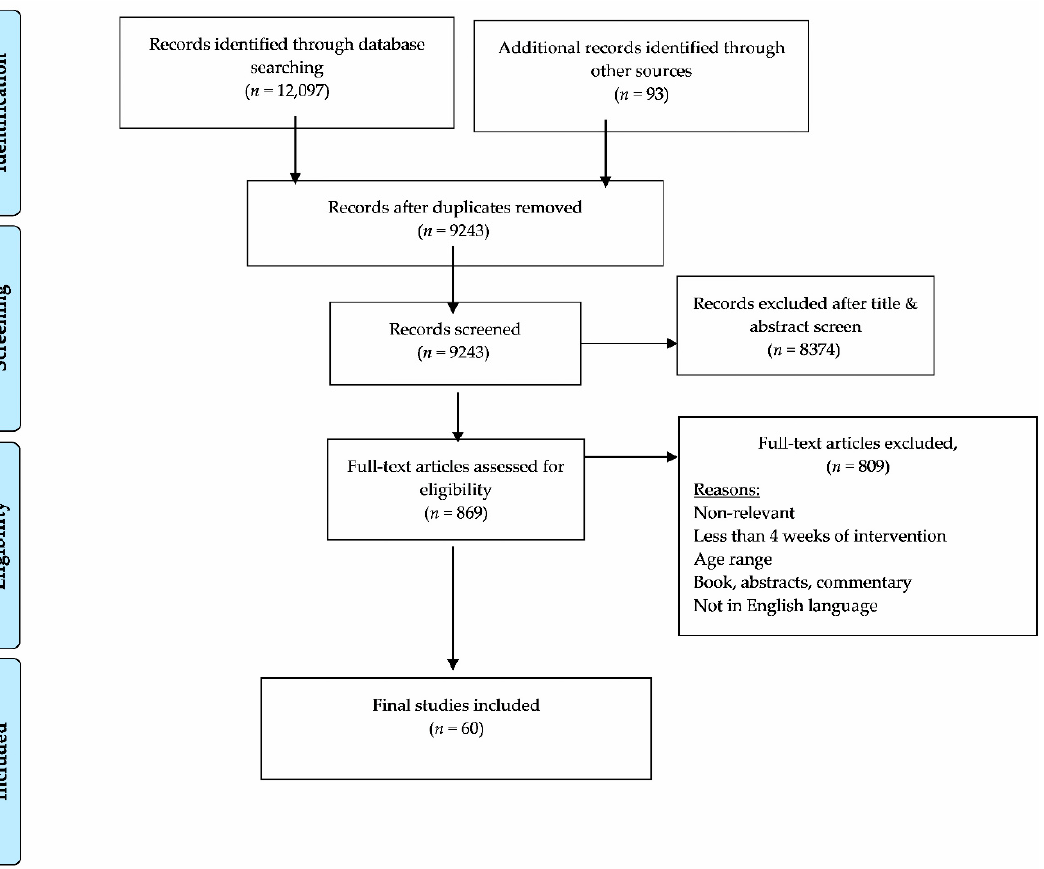
Figure 1. PRISMA Flow Diagram: Identification, screening, eligibility, and inclusion of studies.